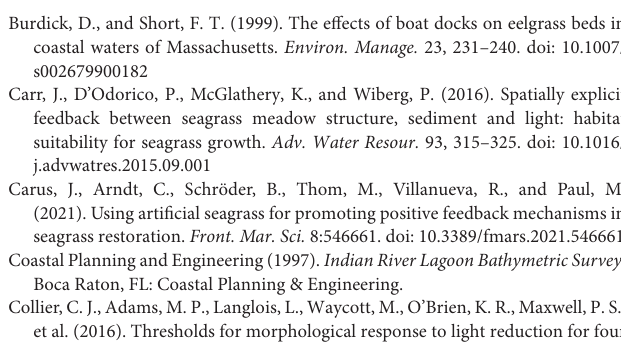
Supplementary Figure 1 | Illustration showing how beds of seagrass that persisted in 10-11 maps (dark green polygons) fell within the mid, 0.5–0.9 m, depth zone (yellow